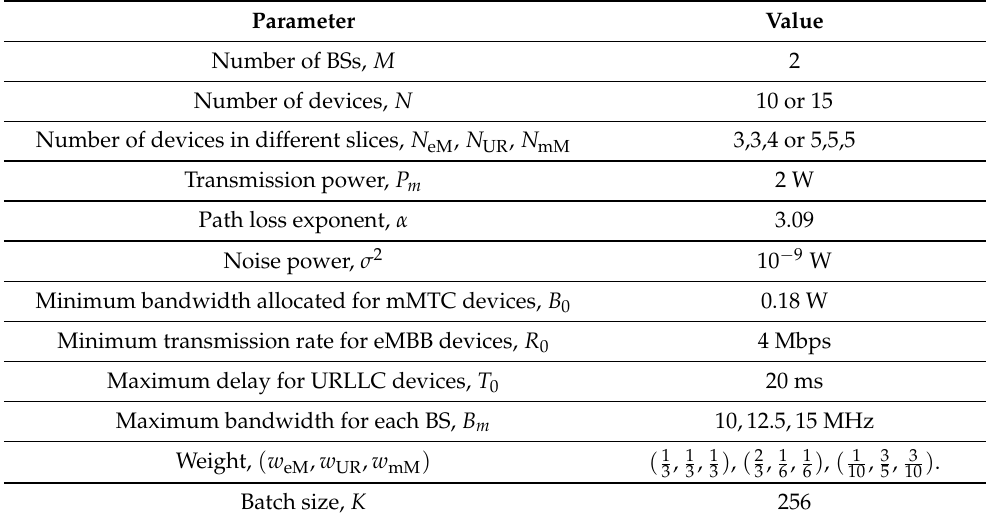
Table 1. Settings of parameters.